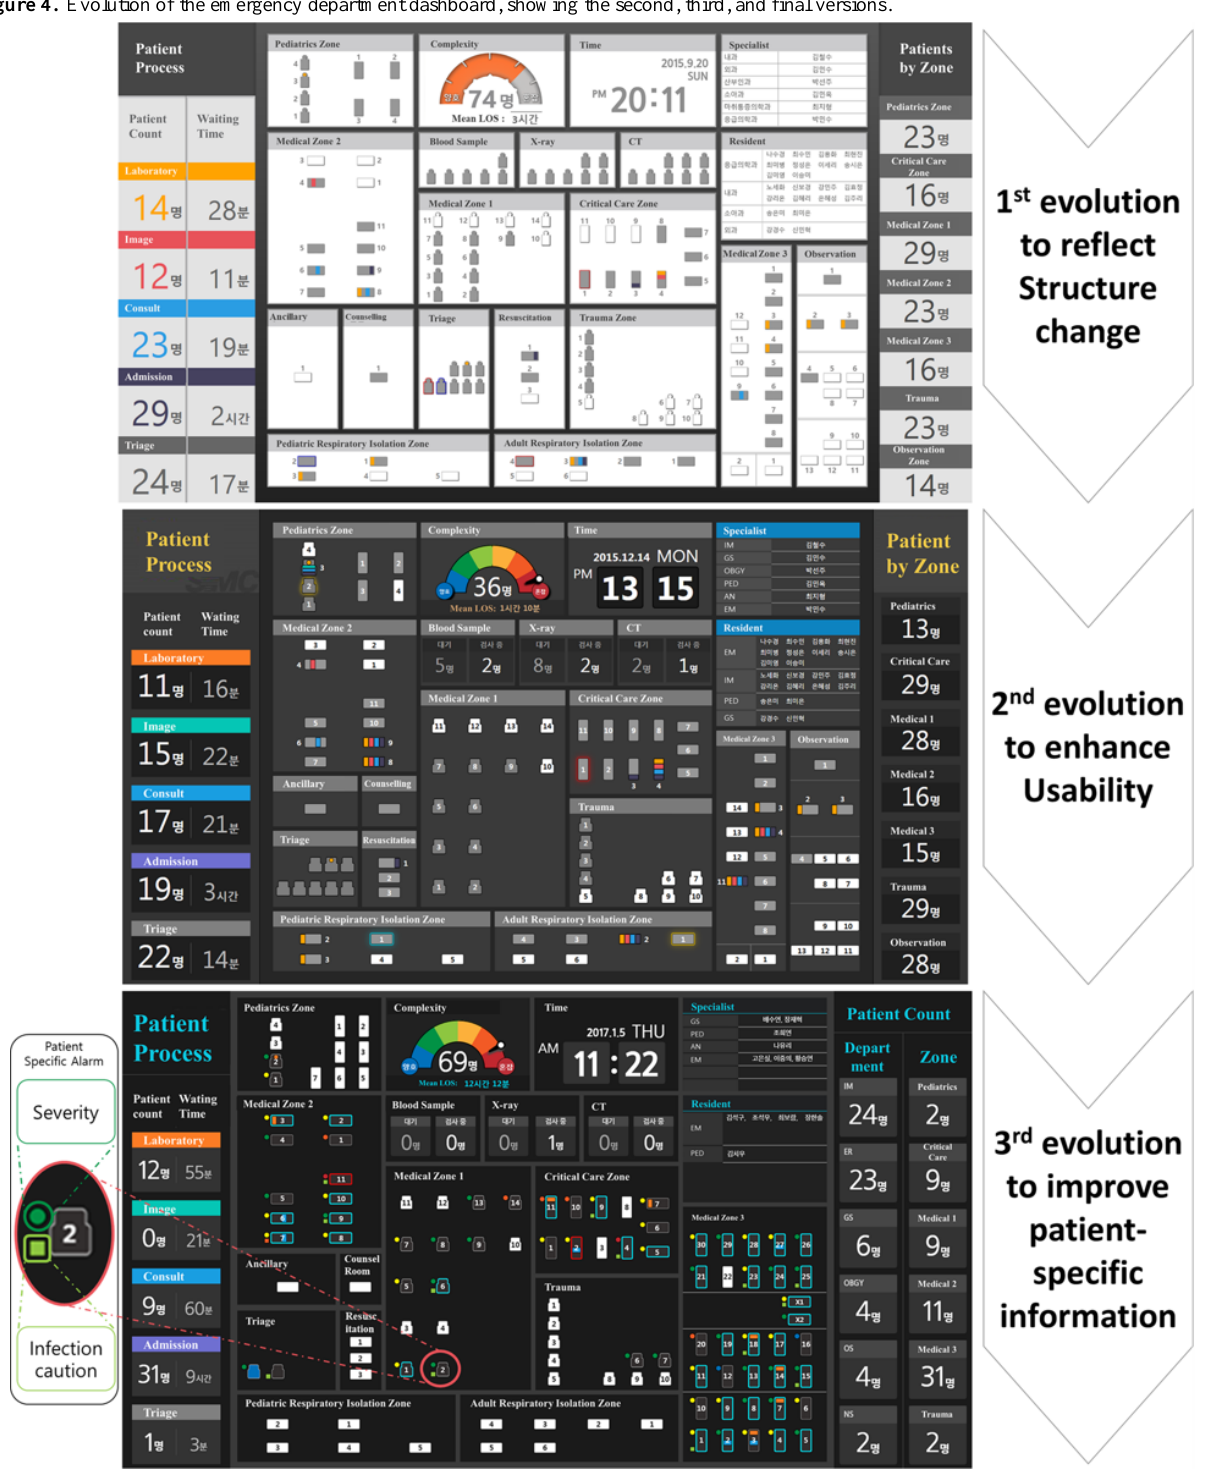
Figure 4. Evolution of the emergency department dashboard, showing the second, third, and final